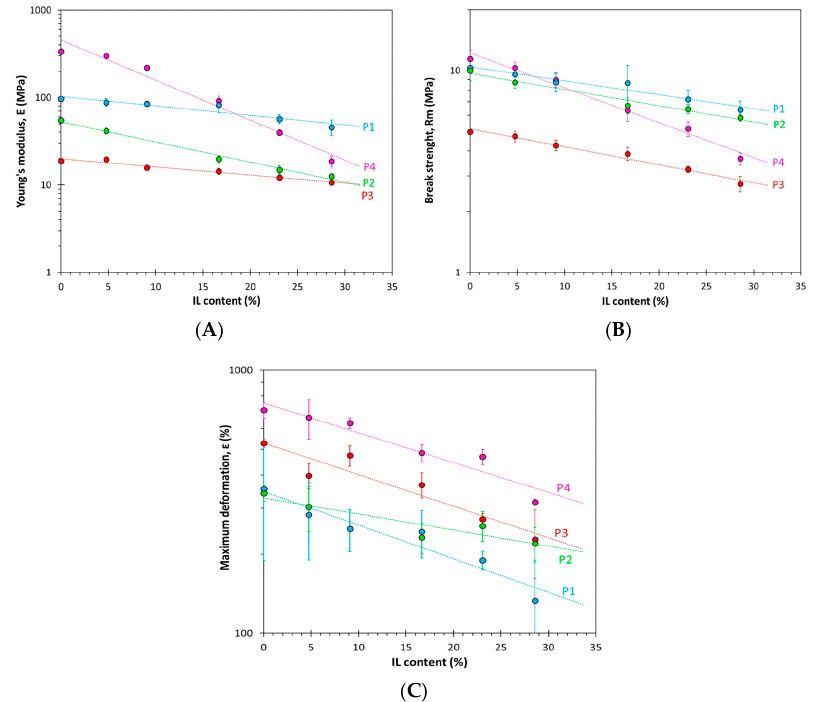
Figure 5. (A ) Young’s modulus, ( B ) tensile strength, and ( C ) maximum elongation of the PolyActive TM /IL membranes as a function of the IL content. Lines are shown as a guide to the eye. Points and error bars indicate the average and standard deviation of 4–5 specimens of each membrane sample.